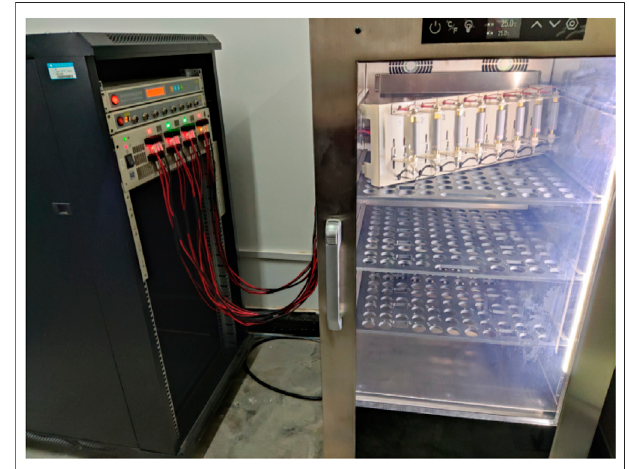
FIGURE 2 | The HPPC test